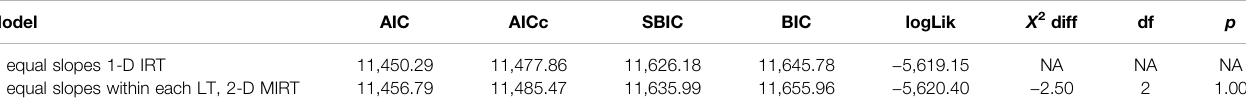
TABLE 4 | Comparison of fi t statistics of two Con fi rmatory IRT models.